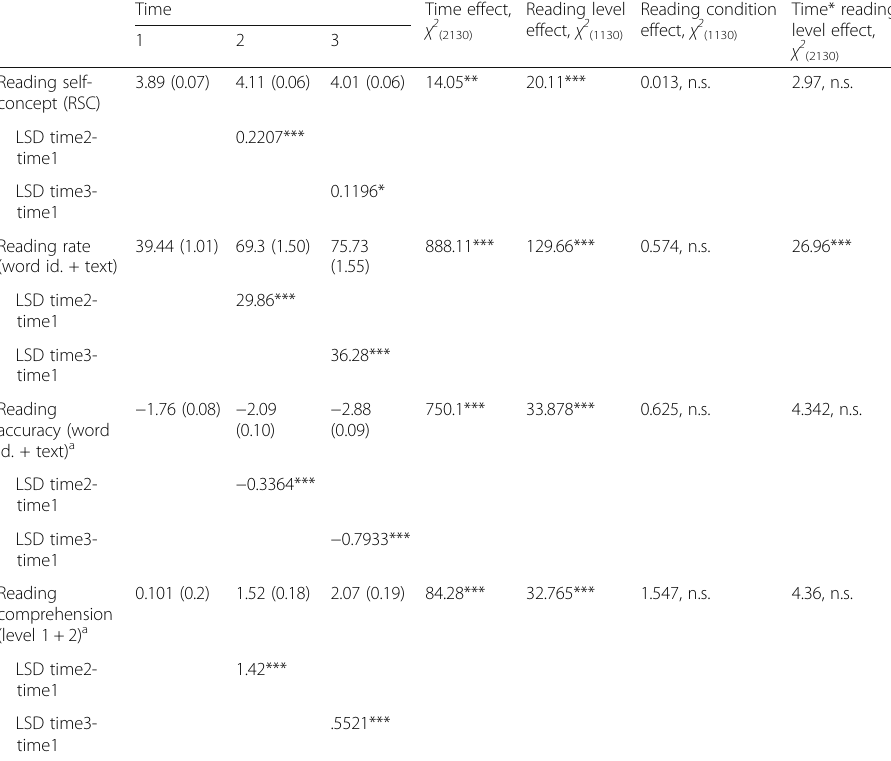
Table 6 Reading self-concept, reading rate, reading accuracy, and reading comprehension effects across time Time Time effect, χ 2